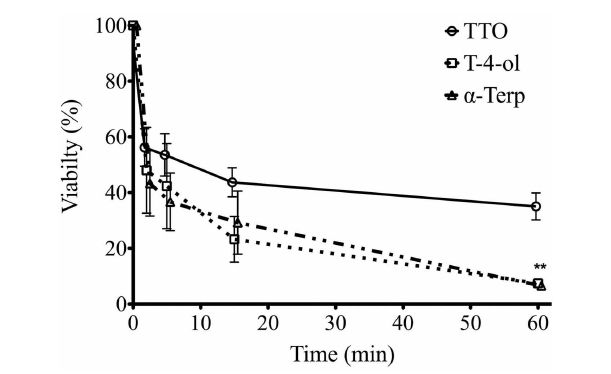
FIGURE 1 | Candida albicans biofilm killing byTTO,T-4-ol, and α -terpineol is time dependent. Standardized C. albicans (1 × 10 6 cells/ml) were incubated in flat-bottomed 96-well plates for 24h, washed in PBS, and treated with 2 × SMIC 50 at 2, 5, 10, 15, and 60min. Metabolic activity of treated biofilms was then quantified using the XTT assay by reading at 492nm in a microtiter plate reader (FluoStar Omega, BMG Labtech).Three isolates were used for each assay, and this was performed on two independent occasions in triplicate. ** p < 0.001. Error bars represent the ± standard error of the